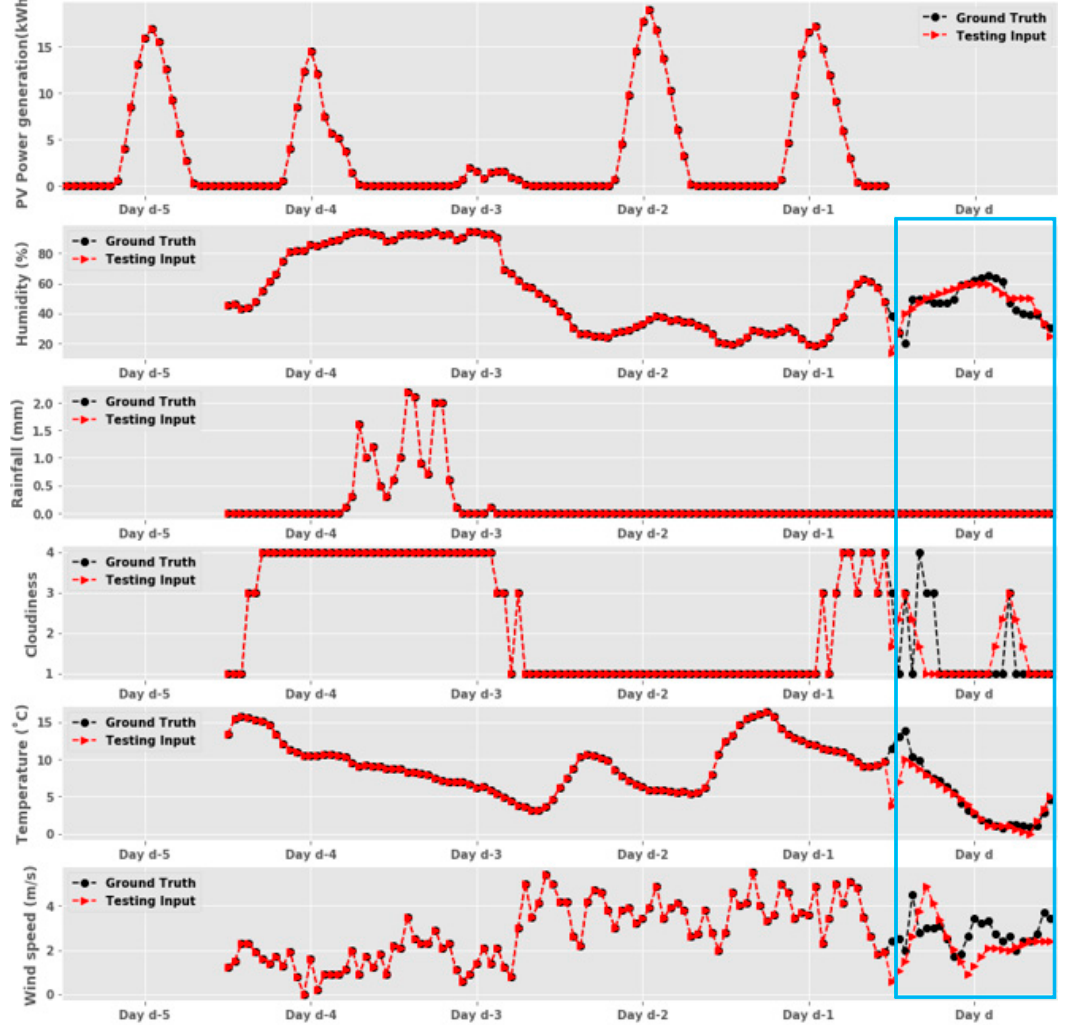
Figure 5. Example of Photovoltaic (PV) power generation and weather data used for the testing phase .